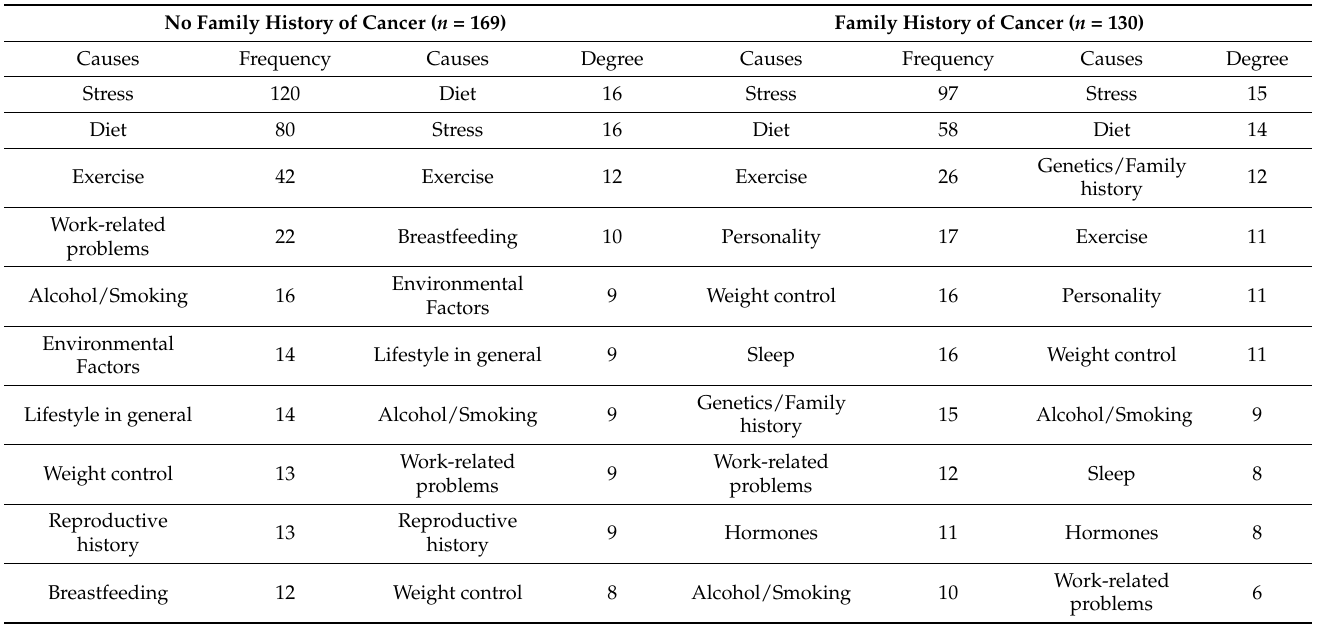
Table 4. The nodes with the frequency and degree of patients with no family history of cancer and a family history of cancer. No Family History of Cancer ( n =